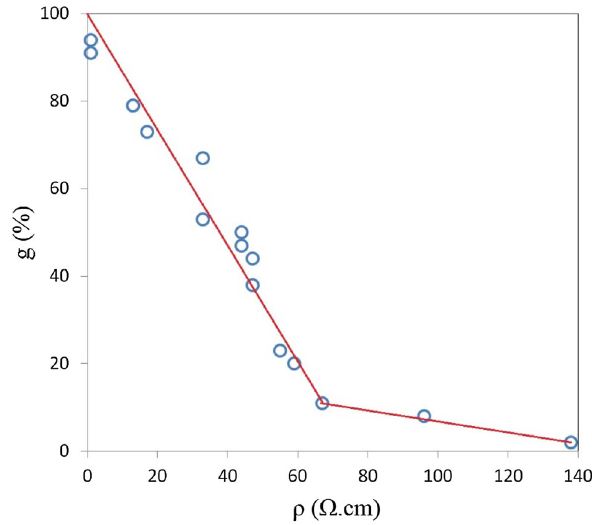
Fig. 7 Linear dependency of g vs. q for the graphitized samples of ethane-based